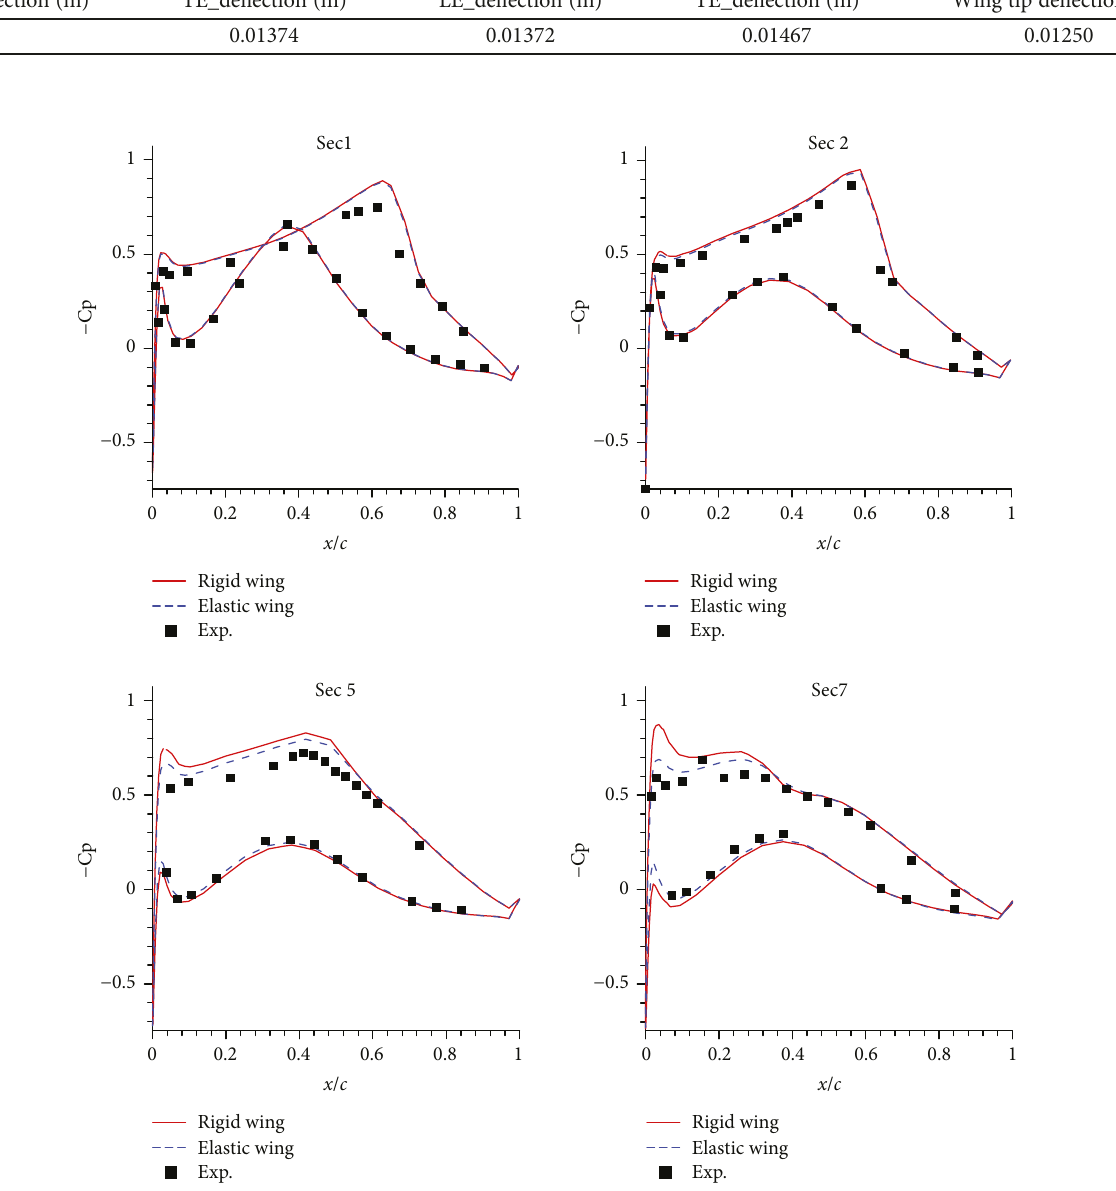
Figure 8: The rigid steady and static aeroelastic surface pressure comparison at sections 1, 2, 5, and